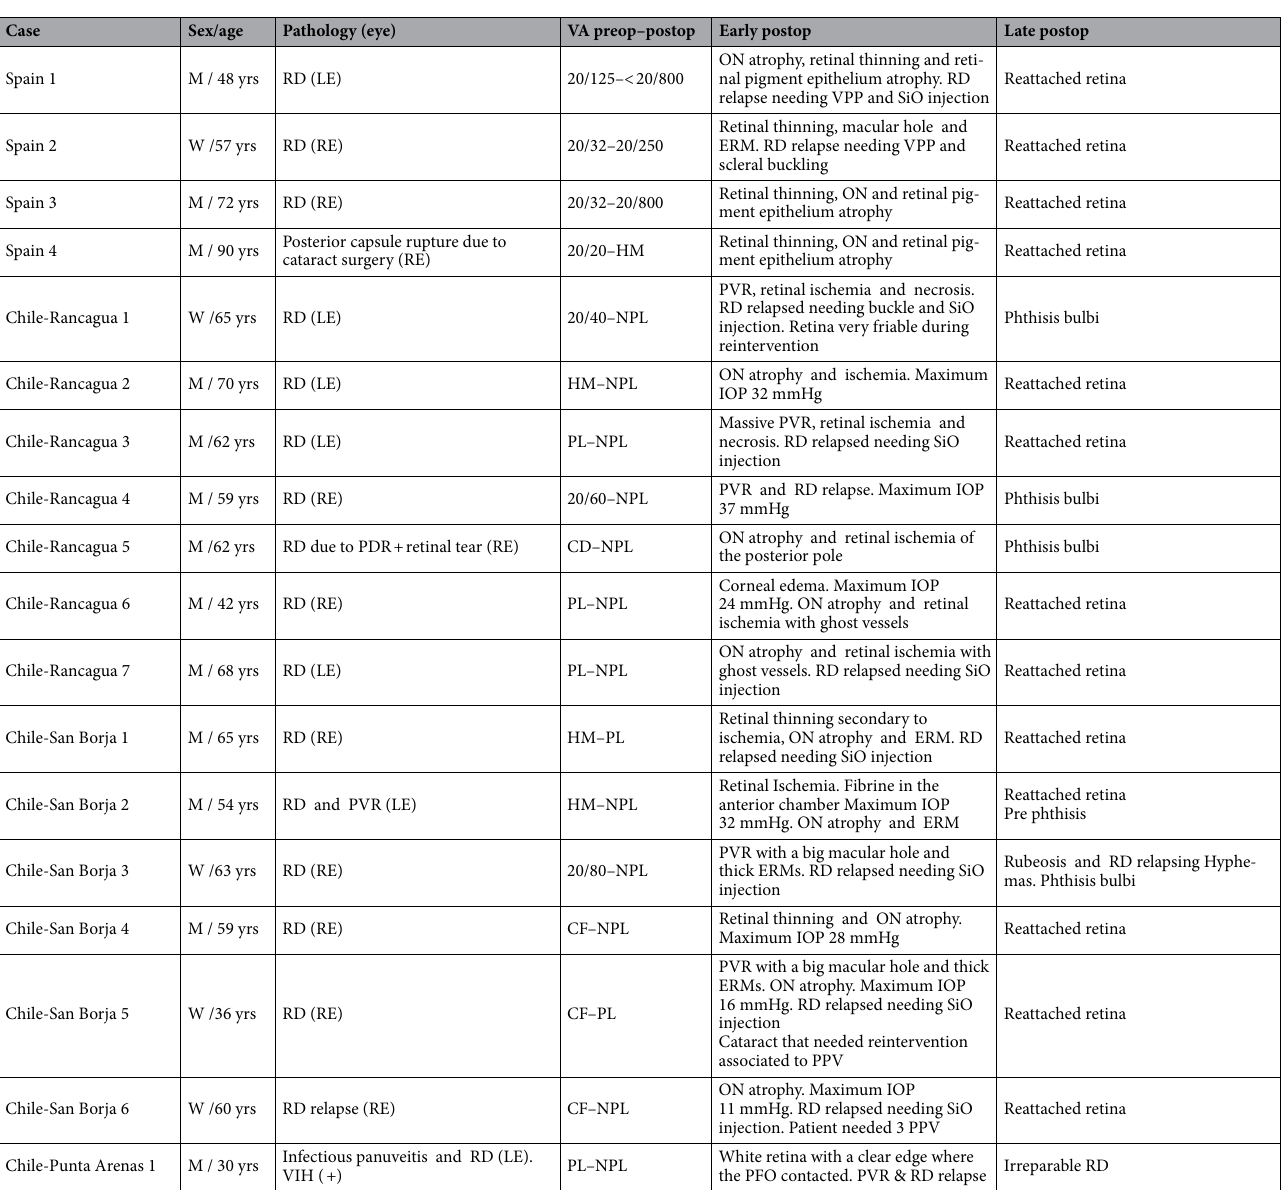
Table 1. Clinical data. Batch numbers from Chile: OCT.01.2013 for all cases. Batch from Spain was OCT.07.2013. The last two cases were initially operated with PPV + SiO, in all others PPV + gas was performed as primary surgery. VA visual acuity, preop preoperative, postop postoperative, RD retinal detachment, PDR proliferative diabetic retinopathy, PVR proliferative vitreoretinopathy, M male, W woman, RE right eye, LE left eye, CF counting fingers, HM hand movements, CF counting fingers, PL perception of light, NPL no perception of light, SiO silicon oil, ON optic nerve, IOP intraocular pressure, ERM epiretinal membrane, PPV pars plana